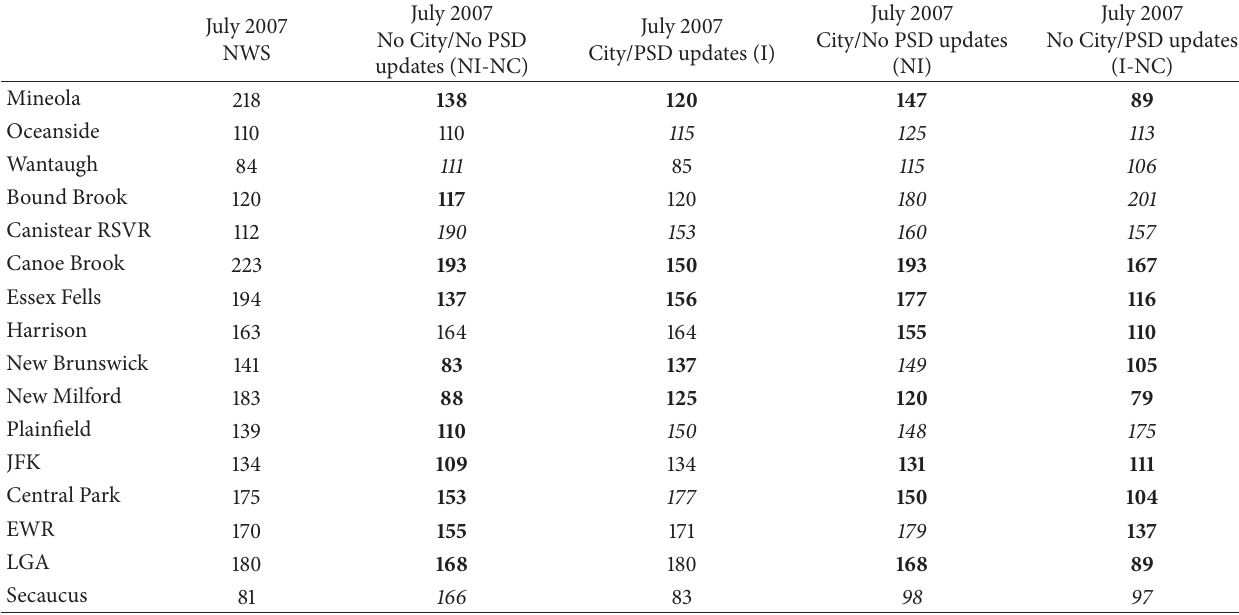
Table 2: Total monthly precipitation (in mm) for July 2007 runs. Blue depicts positive biases, red depicts negative biases, and black depicts total accumulated precipitation differences of 1mm between NWS values and simulated results.